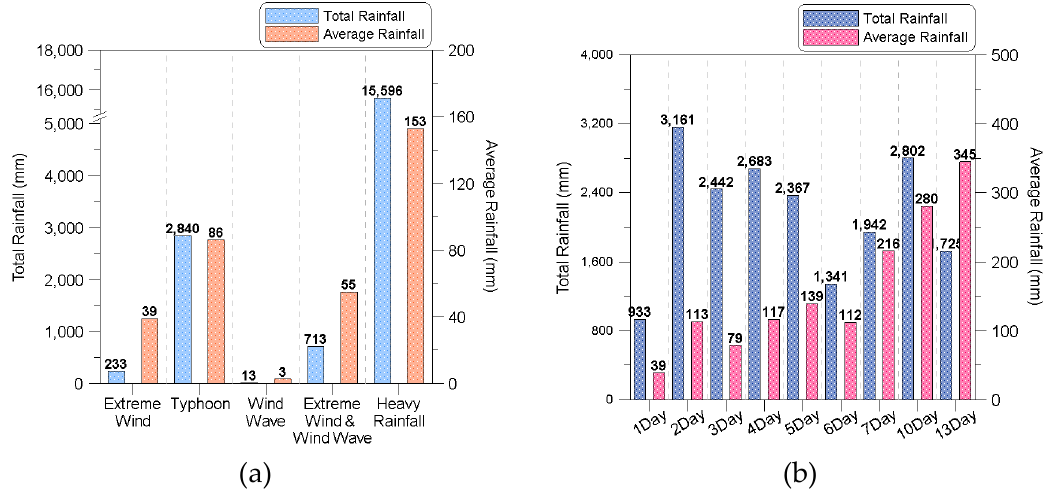
Figure 4. Total rainfall and average rainfall based on occurrence of natural disaster damages (2010–2017): (a) rainfall characteristics by natural disaster type; (b) rainfall characteristics by length of disaster ( a ) rainfall characteristics by natural disaster type; ( b ) rainfall characteristics by length of disaster occurrence period. occurrence period.